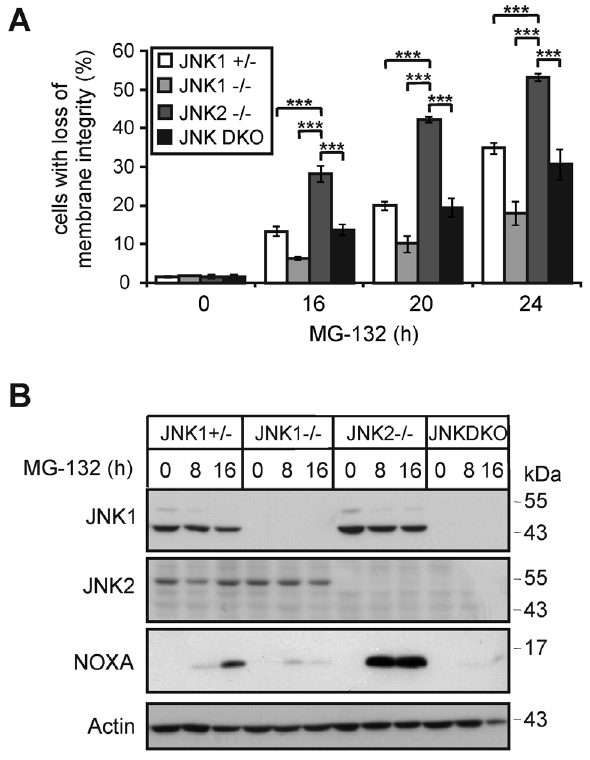
Figure 5. JNK1/2-dependent cell death induction and Noxa expression following MG-132 exposure. ( A ) Cytometric determi- nation of cell death (propidium iodide uptake) of the indicated MEF lines treated with MG-132 as indicated. Values represent the mean of three independent experiments + / 2 SD. *** p , 0.005 according to ANOVA Tukeys test in a time-matched comparison as indicated. ( B ) Western blots for JNK1, JNK2, Noxa and b -actin in the indicated cell lines treated with MG-132 as indicated. One representative experiment out of three is shown.